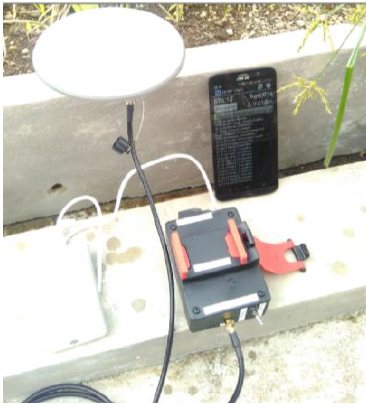
Fig. 10. Equipments used in the experiment